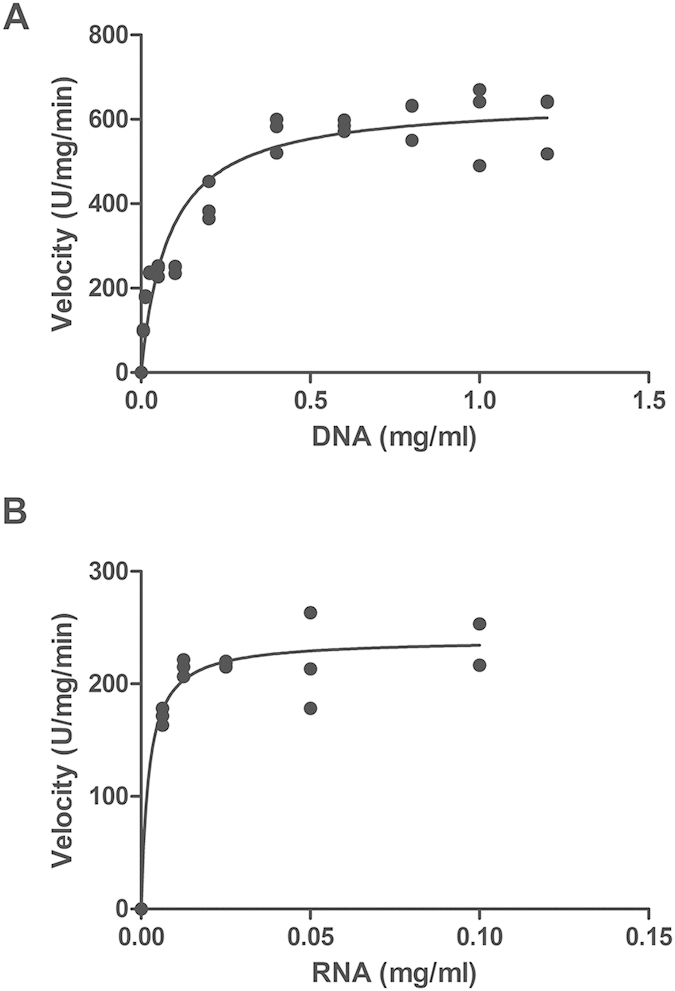
Michaelis-Menton kinetics assays of the DNase (A) and the RNase (B) activity of Rv0888. The reaction was performed in 20 mM Tris-HCl pH 6.5, 5 mM CaCl2 and 5 mM MnCl2 for 1 h at 41 °C. Km values for DNA and RNA were 0.306 ± 0.04 mg/mL and 0.012 ± 0.01 mg/mL, respectively; the Vmax values for DNase and RNase activity were 600.56 U/mg/min and 241.11 U/mg/min, respectively.